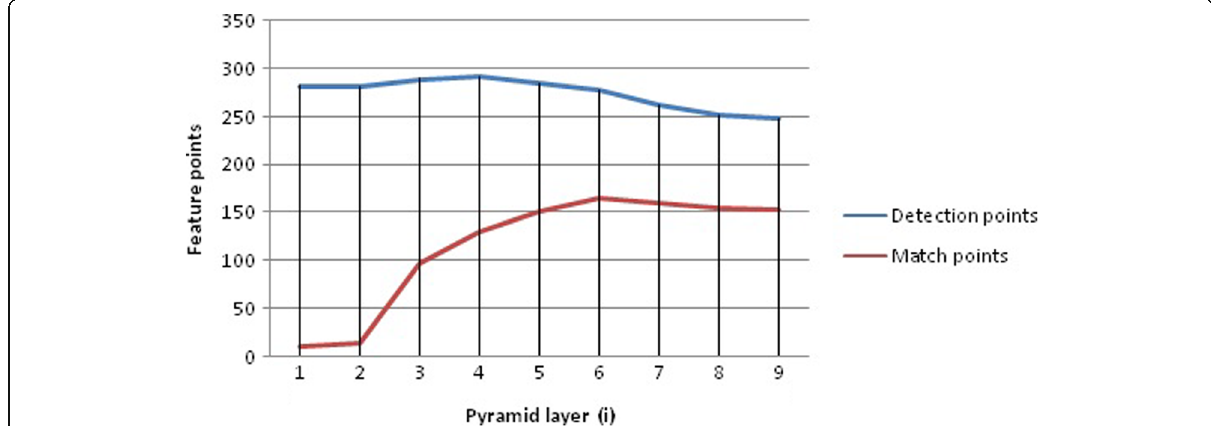
Fig. 31 Comparison of the number of feature points detected and the number of exact matches when the number of pyramid layers